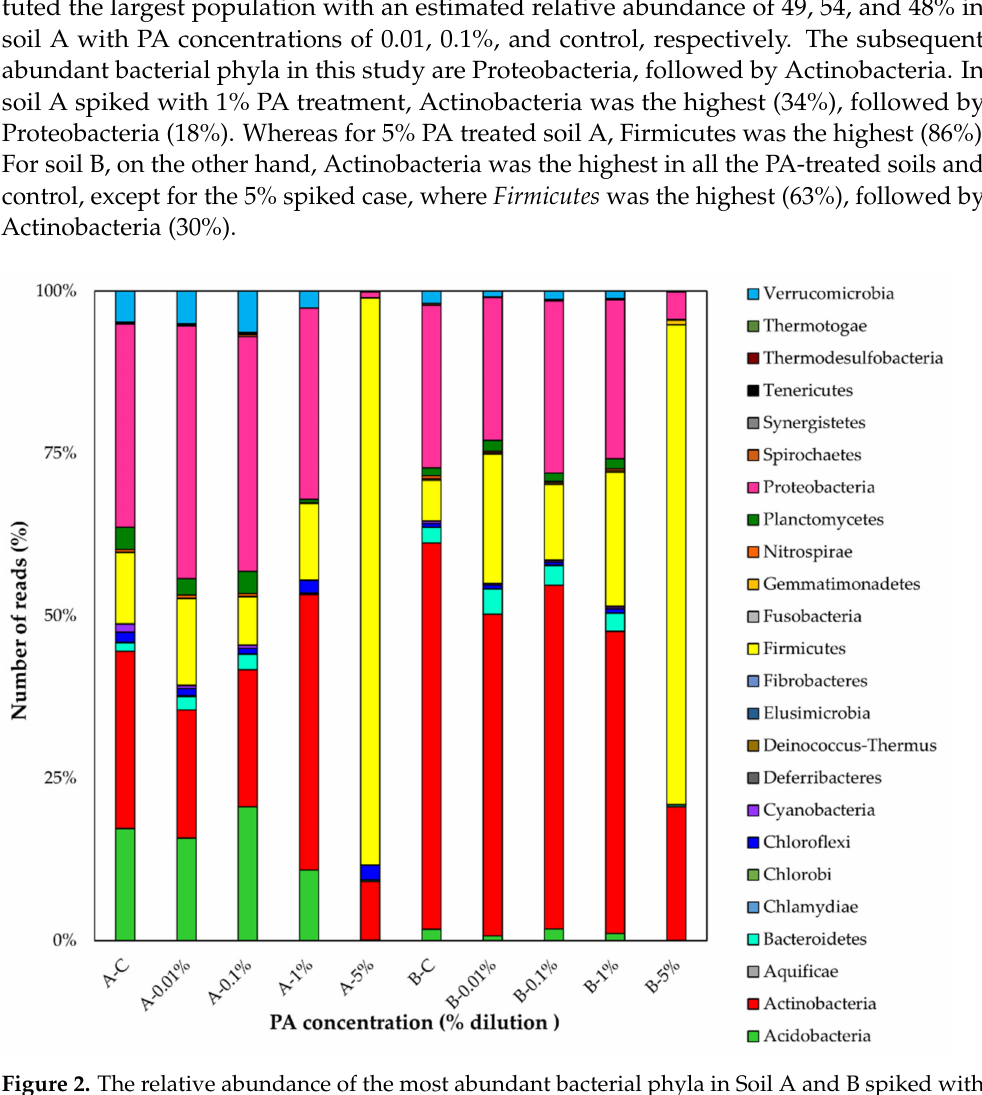
Figure 2. The relative abundance of the most abundant bacterial phyla in Soil A and B spiked with different concentrations of PA (control (C), 0.01%, 0.1%, 1%, and